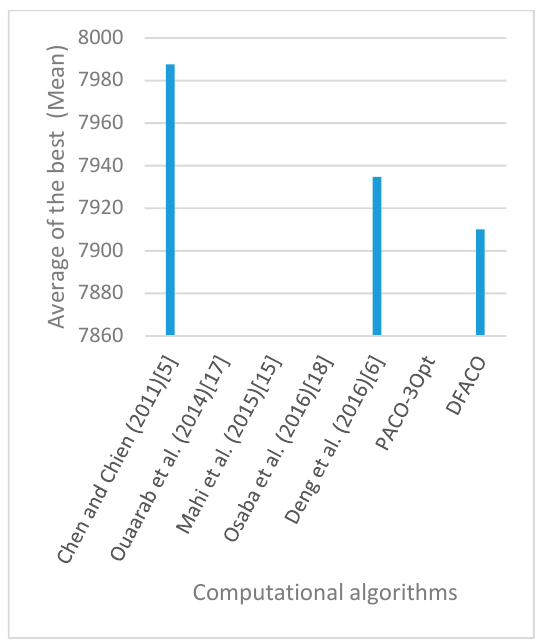
Figure 15. Average of best solutions obtained for instance rd100 by all algorithms.